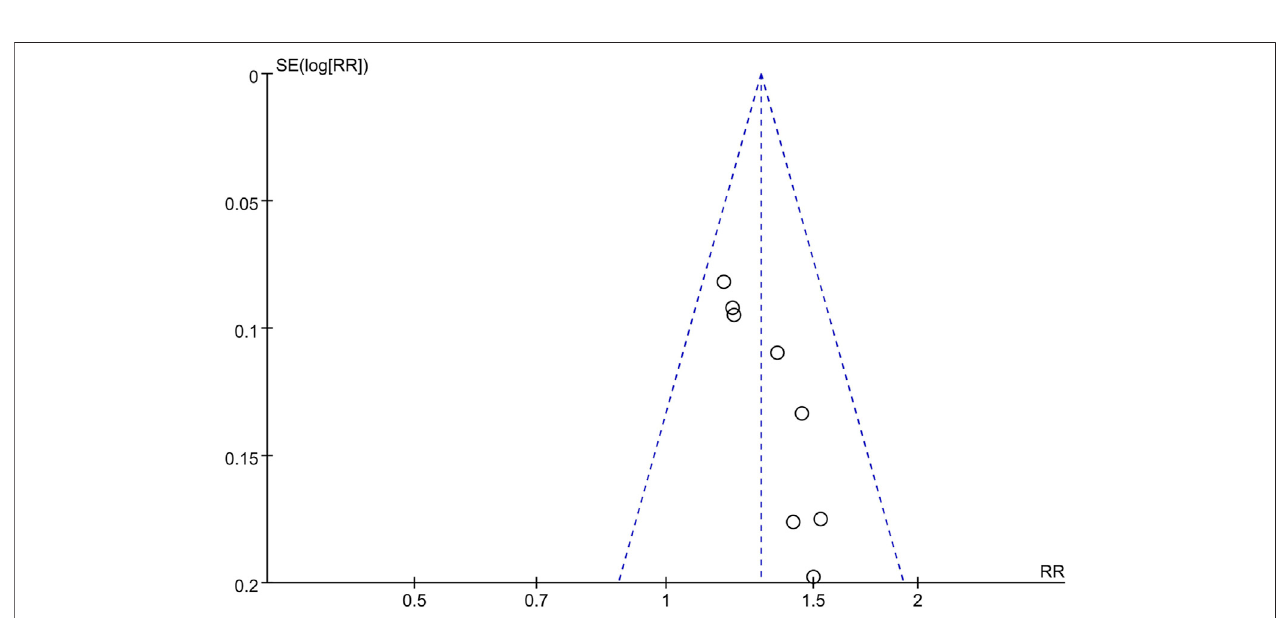
FIGURE 9 | Funnel plot of the overall response